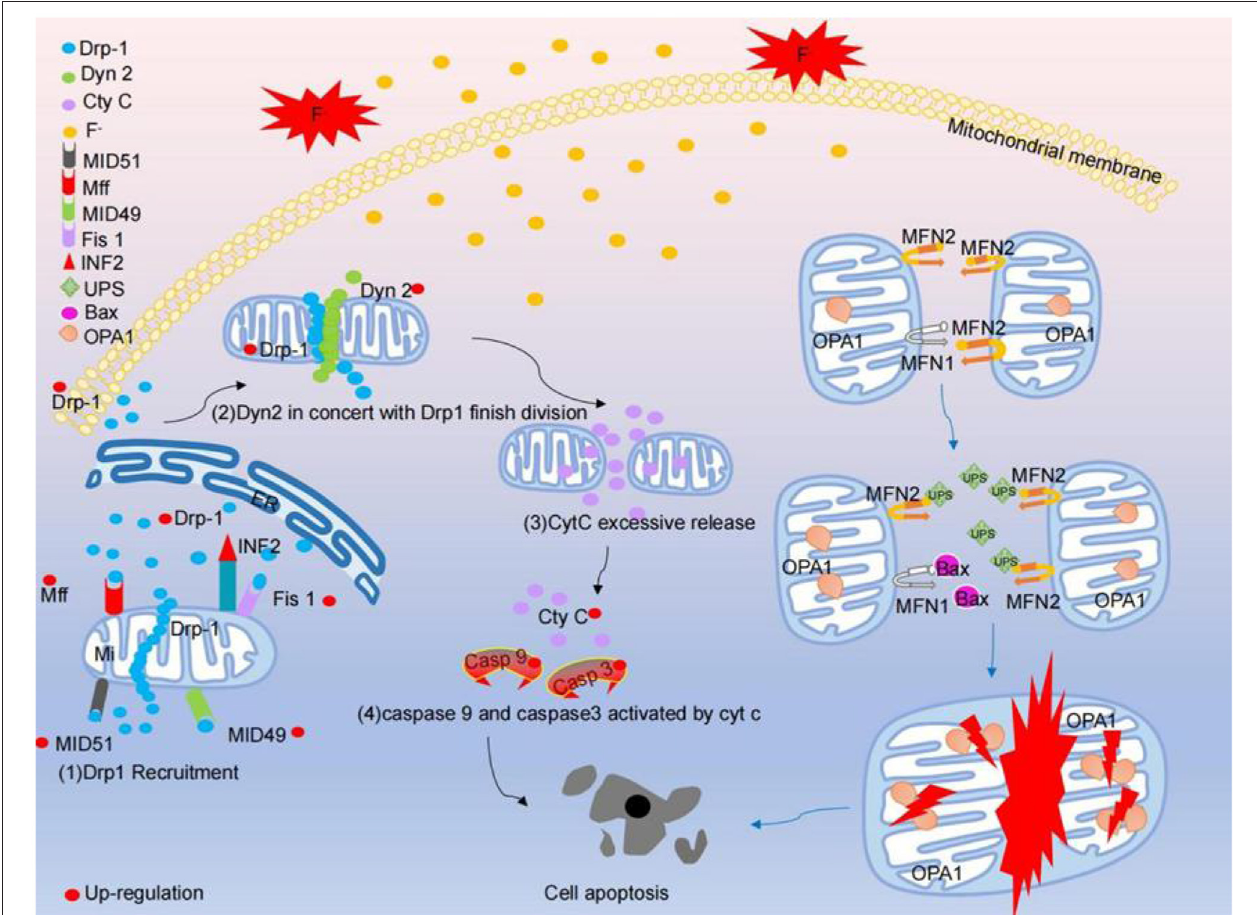
FIGURE 2 | Fluoride stimulates mitochondria, causing excessive mitosis and fusion disorders that result in apoptosis. Fluoride stimulates the fission pathway of mitochondria: (1) The expression of Mff, Fis1, MiD49 and MiD51 on the surface of mitochondria increased, and Drp1 was recruited from cytoplasm and endoplasmic reticulum. A large number of Drp1 form a circular structure in the middle of the mitochondria and compress the mitochondria. (2) Dyn2 and Drp1 are up-regulated together to finalize the division of mitochondria. (3) Excessive mitosis of mitochondria lead to structural damage of mitochondria, resulting in excessive release of Cyt c from the interior of mitochondria in the cytoplasm. (4) Caspase 9 and Caspase 3 are activated and eventually lead to apoptosis (5) (50). The mitochondrial fusion pathway stimulated by fluoride: after fluoride stimulation, the binding of mitochondrial surface fusion protein MFN1 to Bax increased, the UPS (ubiquitin-proteasome) in mitochondrial surface fusion protein MFN2 degraded, and the activity of mitochondrial membrane fusion protein OPA1 decreased, which comprehensively destroyed the process of mitochondrial fusion and finally led to